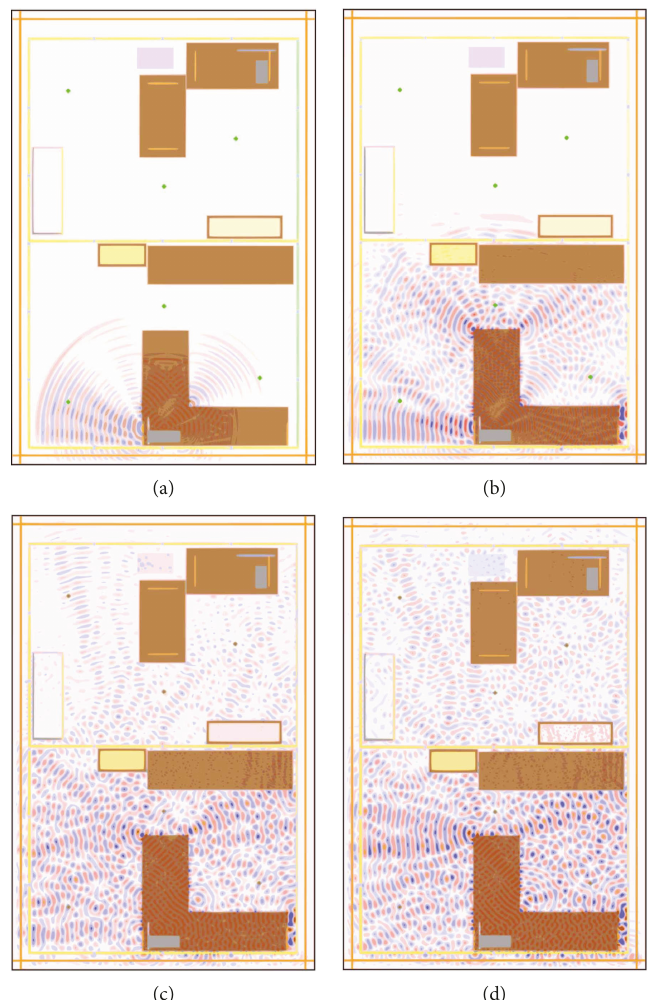
n = 450 , 1050, 2050,